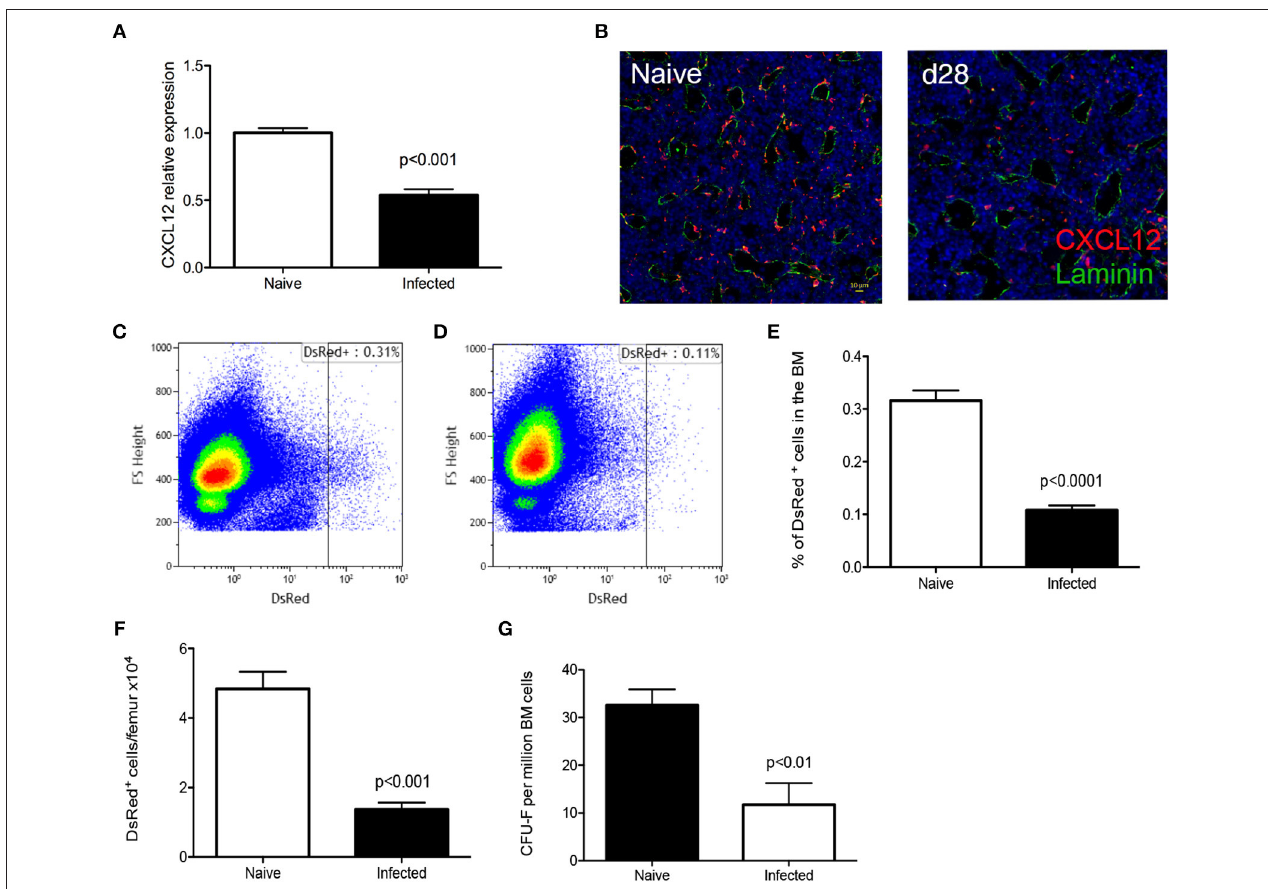
FIGURE 4 | L. donovani infection causes a reduction in CXCL-12-expressing cells in the BM. (A) Cxcl12 mRNA accumulation in BM of naïve and infected mice, determined by qRT-PCR. (B) Visualization of CXCL12-expressing cells using naïve and infected Cxcl12 -DsRed reporter mice. Sectioned were co-stained for laminin (green) and counterstained with DAPI (blue). (C,D) Flow cytometry analysis of DsRed + cells in naïve (C) and infected (D) Cxcl12 -DsRed reporter mice. Dot plots show identical number of cells, gated on live single cells. (E) Frequency of DsRed + cells. (F) Absolute number of DsRed + cells per femur, calculated from the frequency of DsRed + cells in (E) multiplied by the total bone marrow cell count (Mann Whitney test; Data from five naïve mice and nine infected mice from two independent experiments). (G) Number of CFU-F per million BM cells (Unpaired t -test; n = 7 mice per group from two independent experiments). Data represent mean ± SEM. All experiments were performed 28 days post-infection with L. donovani